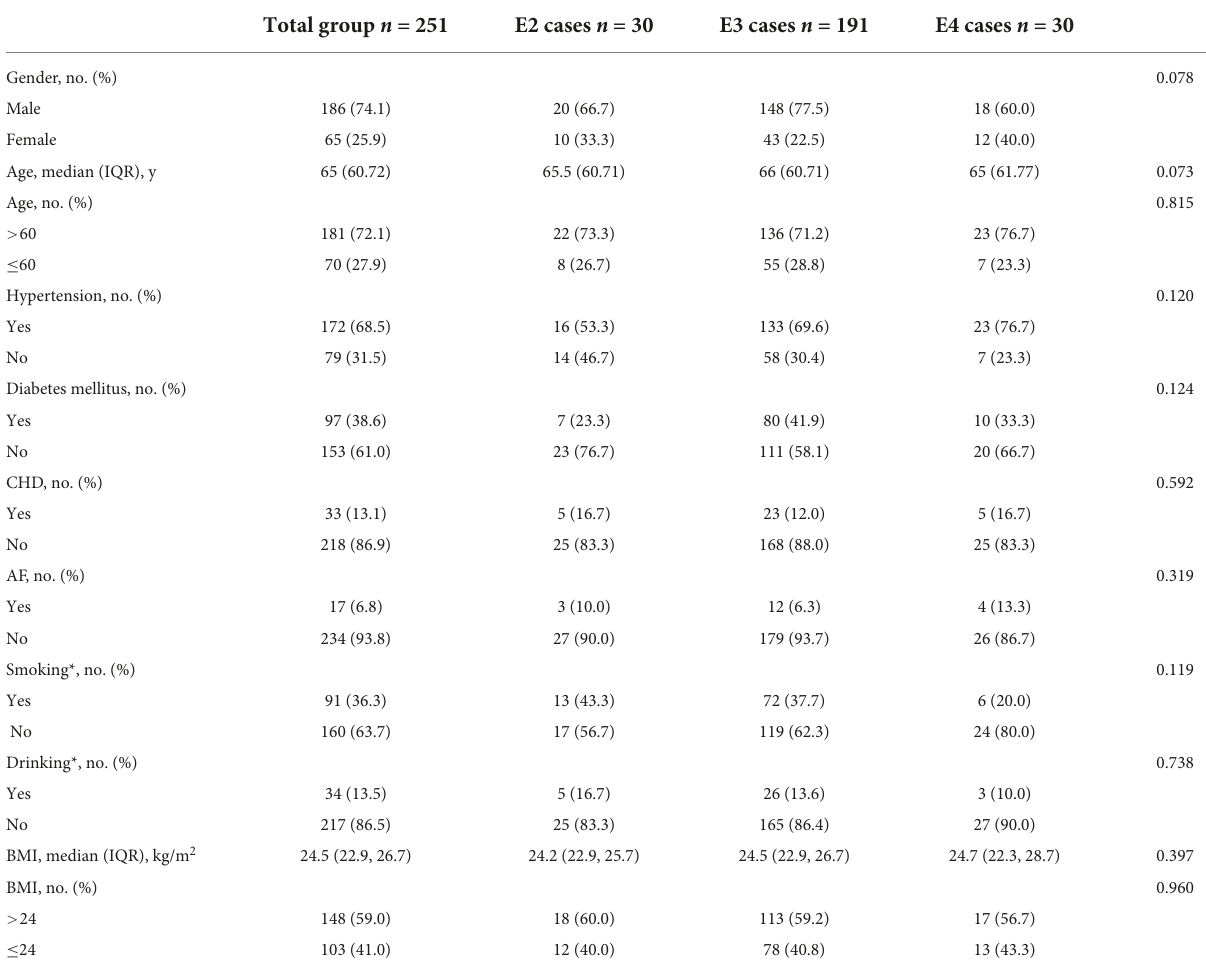
TABLE 2 Characteristics of the patients at